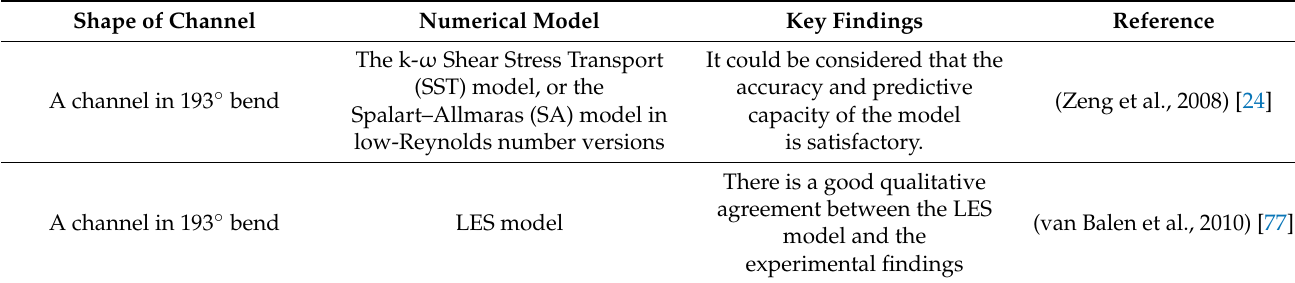
Table 4. Summary of studies about bend over topography used in Section